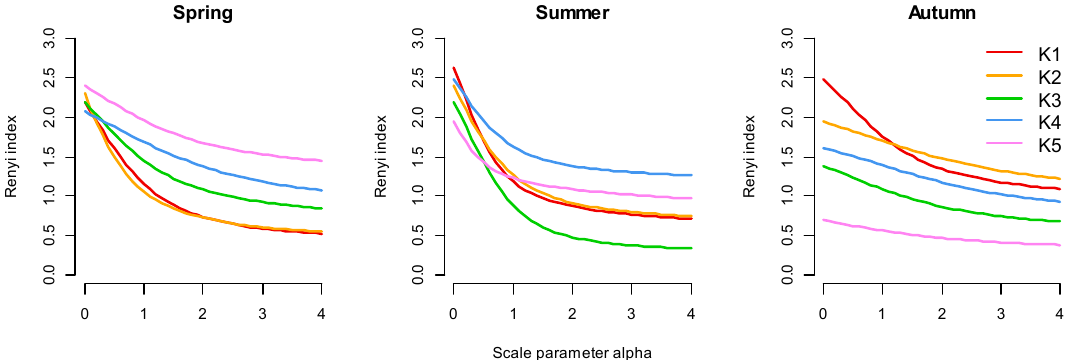
Figure 3. R é nyi diversity profiles of the seasonal rotifer assemblages at di ff erent distances (K1–K5) Figure 3. Rényi diversity profiles of the seasonal rotifer assemblages at different distances (K1–K5) from the inflow point in the K á kafok oxbow from the inflow point in the Kákafok oxbow lake.